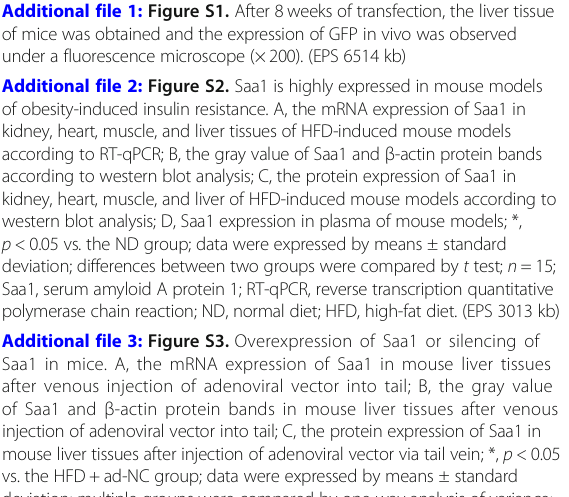
Additional file 1: Figure S1. After 8weeks of transfection, the liver tissue of mice was obtained and the expression of GFP in vivo was observed under a fluorescence microscope (×200). (EPS 6514 kb) Additional file 2: Figure S2. Saa1 is highly expressed in mouse models of obesity-induced insulin resistance. A, the mRNA expression of Saa1 in kidney, heart, muscle, and liver tissues of HFD-induced mouse models according to RT-qPCR; B, the gray value of Saa1 and β -actin protein bands according to western blot analysis; C, the protein expression of Saa1 in kidney, heart, muscle, and liver of HFD-induced mouse models according to western blot analysis; D, Saa1 expression in plasma of mouse models; *, p <0.05 vs. the ND group; data were expressed by means ± standard deviation; differences between two groups were compared by t test; n =15; Saa1, serum amyloid A protein 1; RT-qPCR, reverse transcription quantitative Additional file 3: Figure S3. Overexpression of Saa1 or silencing of Saa1 in mice. A, the mRNA expression of Saa1 in mouse liver tissues after venous injection of adenoviral vector into tail; B, the gray value of Saa1 and β -actin protein bands in mouse liver tissues after venous injection of adenoviral vector into tail; C, the protein expression of Saa1 in mouse liver tissues after injection of adenoviral vector via tail vein; *, p <0.05 vs. the HFD+ad-NC group; data were expressed by means ± standard deviation; multiple groups were compared by one-way analysis of variance;